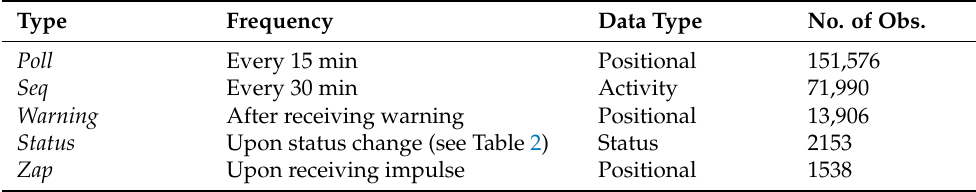
Table 1. Overview of the different message types and description of frequency, data type and number of observations.